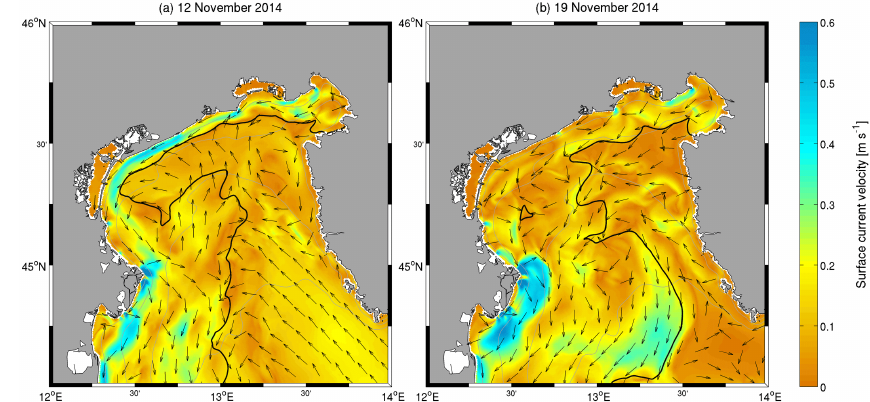
Figure 3. Daily-averaged modelled surface currents velocities in the NAS on 12 November 2014 (a) and 19 November 2014 (b) . Normalized vectors indicating current direction have been subsampled every 15 grid points for graphical purposes; the black thick line indicates modelled isohaline 36.